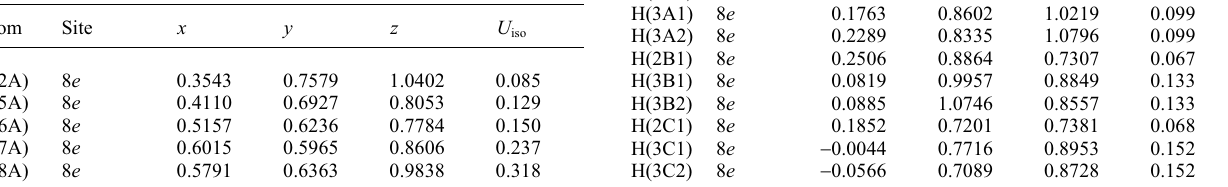
Table 2. Atomic coordinates and displacement parameters (in Å 2 ) .